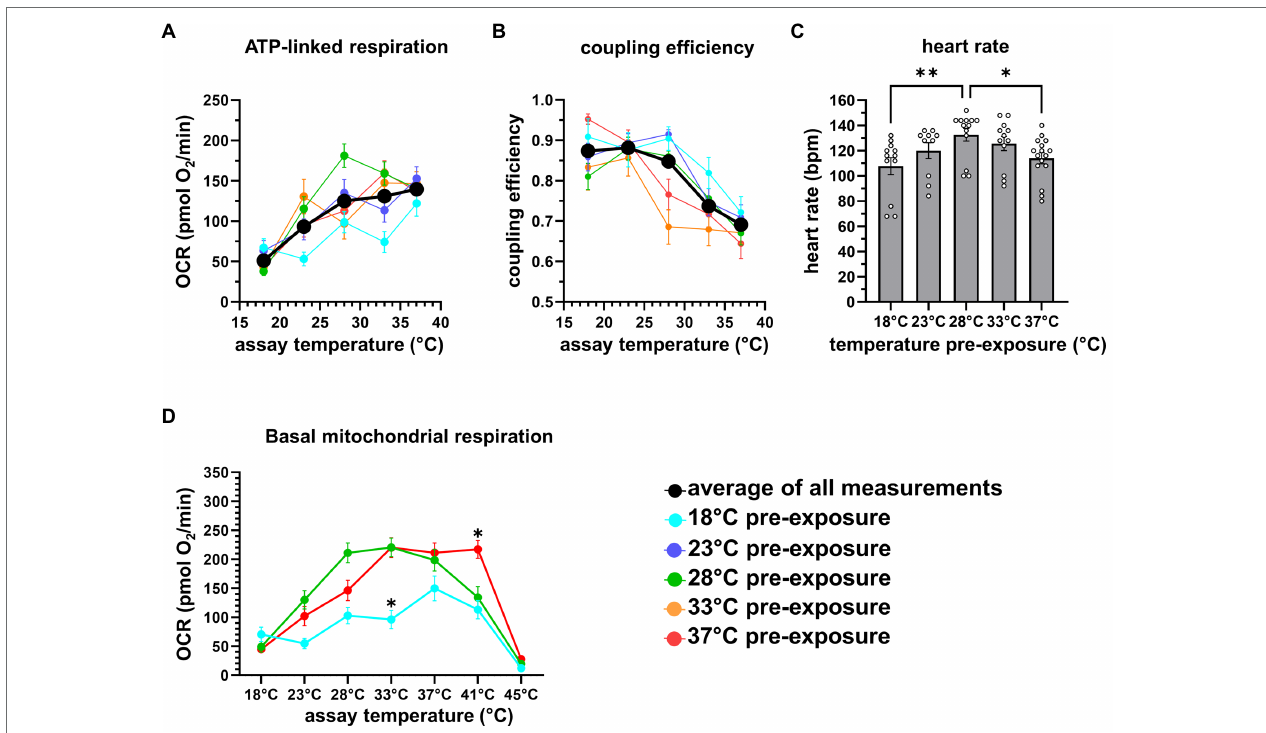
FIGURE 6 | Temperature sensitivity of respiration. (A) Colored traces depict the averages of ATP-linked respiration of different temperature pre-exposures, the black solid trace represents the average of all measurements. (B) Colored traces indicate coupling efficiency of different pre-exposures, the black solid trace represents the average of all measurements. (C) Bar chart depicting the average of the heart rate ( n = 12–14) in response to temperature pre-exposure, measured at room temperature. (D) Basal mitochondrial respiration of 18°C, 28°C, and 37°C pre-exposed embryos is plotted vs. assay temperature, revealing lower respiratory activity of 18°C pre-exposed embryos, and the resilient respiration rates of 37°C vs. 28°C pre-exposed embryos at higher assay temperature. * p < 0.05; ** p <